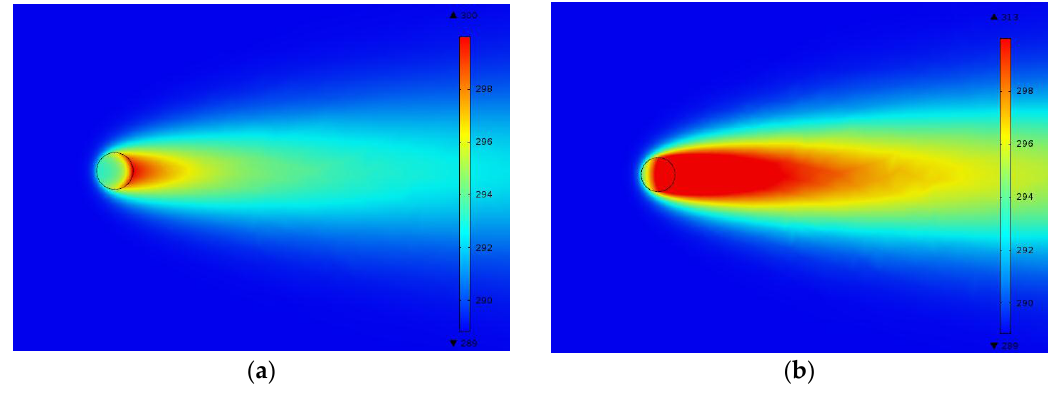
Figure 11. Temperature response after one-month (u = 5.0 × 10 −6 m/s, D/L ratio = 0.025). ( a ) Borehole permeability same as ground); ( b ) Impermeable borehole.